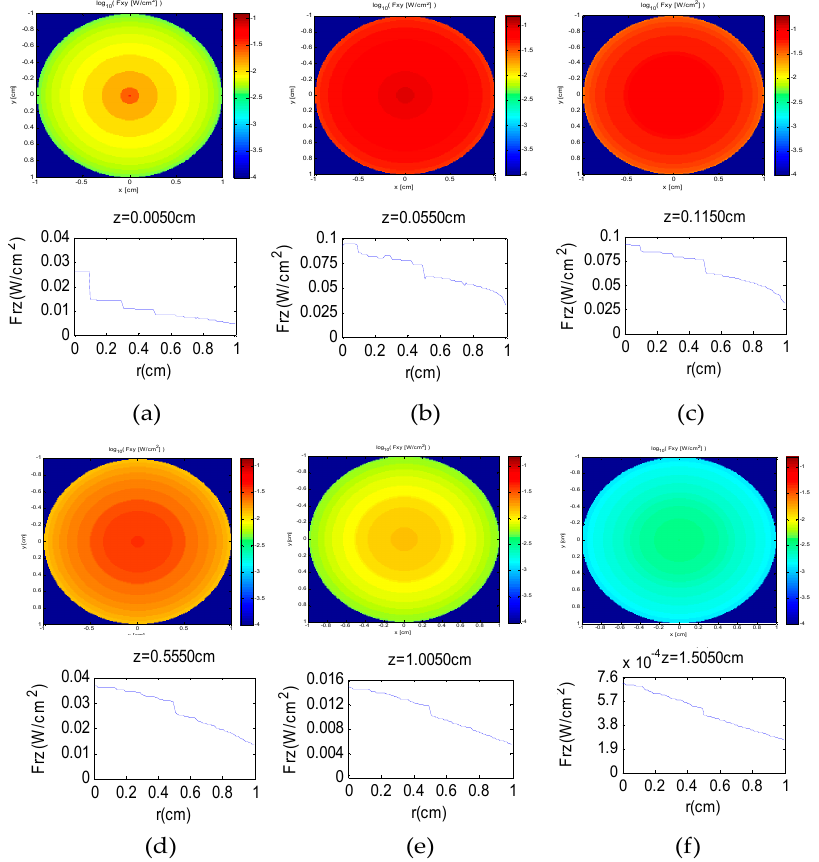
Figure 7. Pseudo-color charts and curve charts of luminous flux along the r axis corresponding to the different depths along the z axis, which include 0.0050 cm ( a ); 0.0550 cm ( b ); 0.1150 cm ( c ); 0.5550 cm ( d ); 1.0050 cm ( e ) and 1.5050 cm ( f ); respectively.